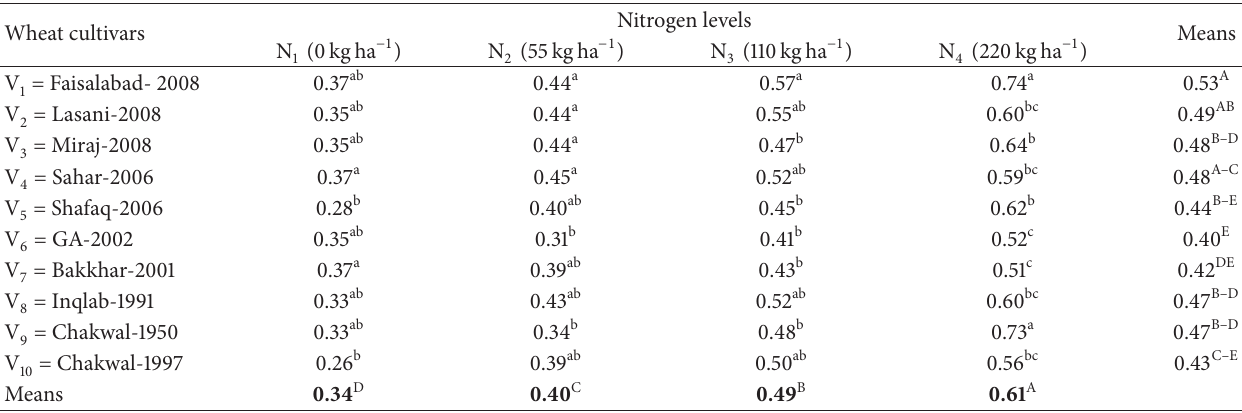
Table 6: Interactive effect of nitrogen levels wheat cultivars for NDVI score at maturity stage for the year 2009-10. Wheat